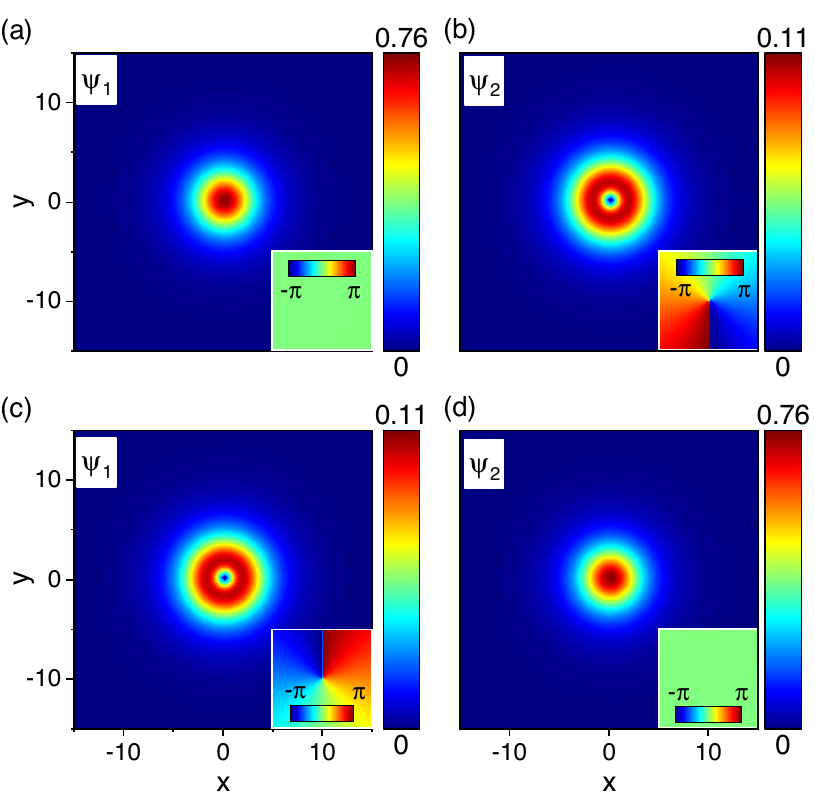
of the bulk soliton at 1 ; 2